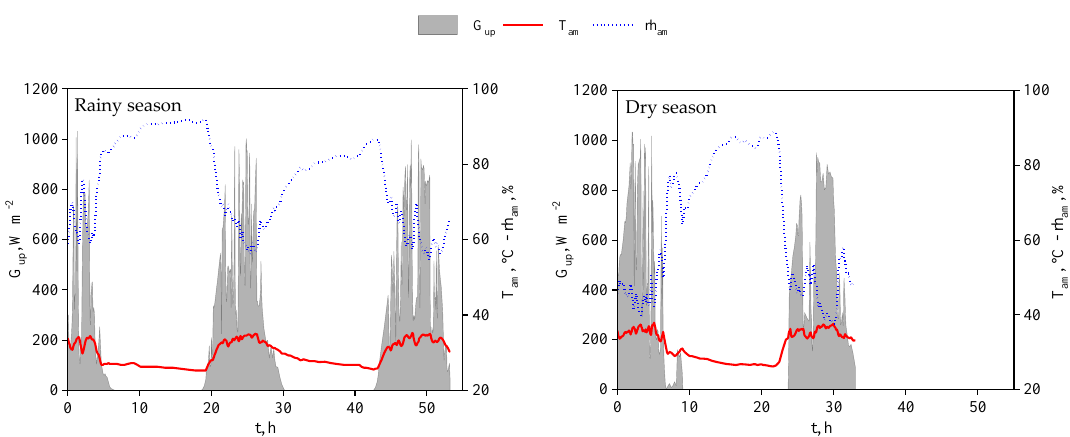
Figure 8. Total solar radiation G up , ambient temperature T am , and relative humidity rh am during an exemplary drying batch in the dry season (22 May 2012) and the rainy season (19 October 2012) at IRRI in Los Baños, Republic of the Philippines (14°9′55′′ N, 121°15′37′′ E).